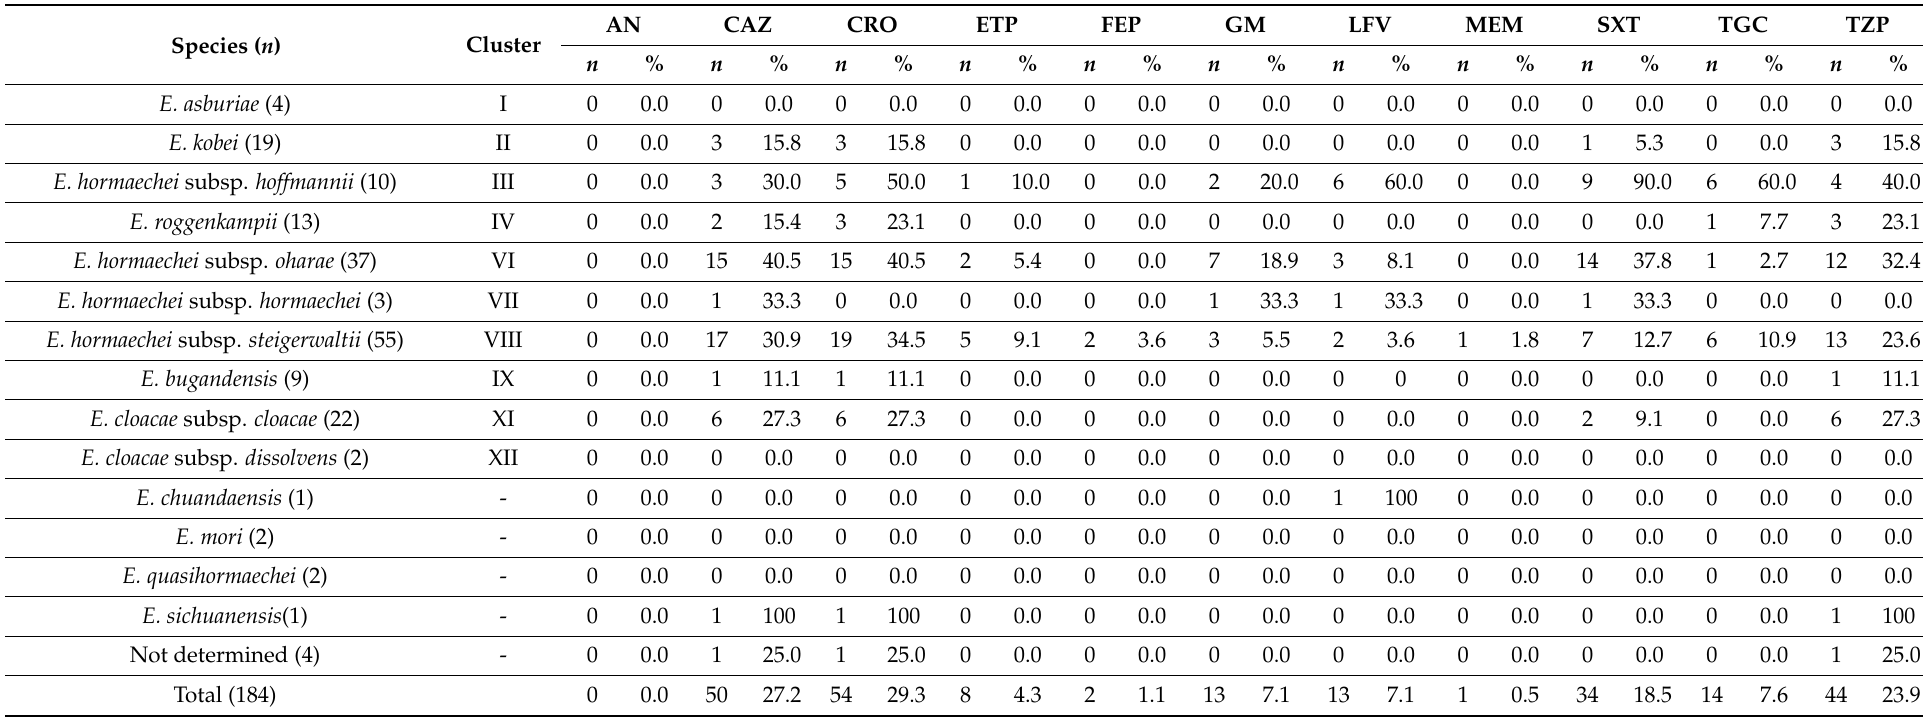
Table 2. Antimicrobial resistance rates in each species of Enterobacter